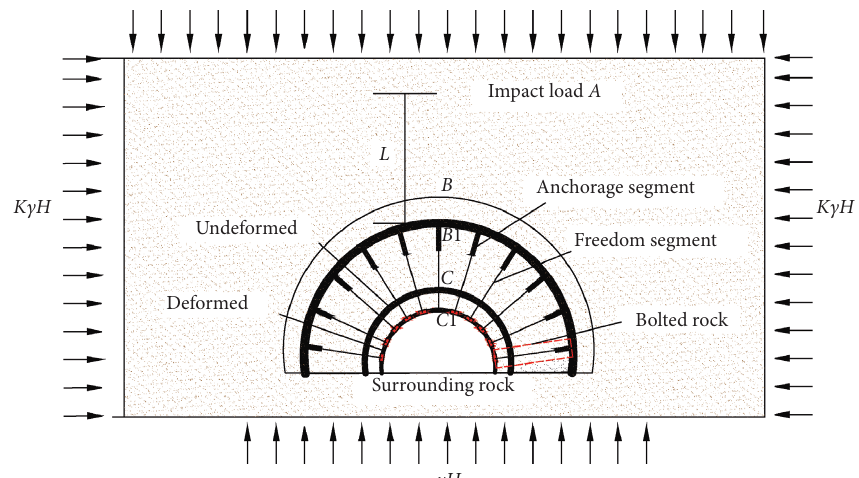
Figure 1: Energy dissipation model of the bolted rock under impact load in the